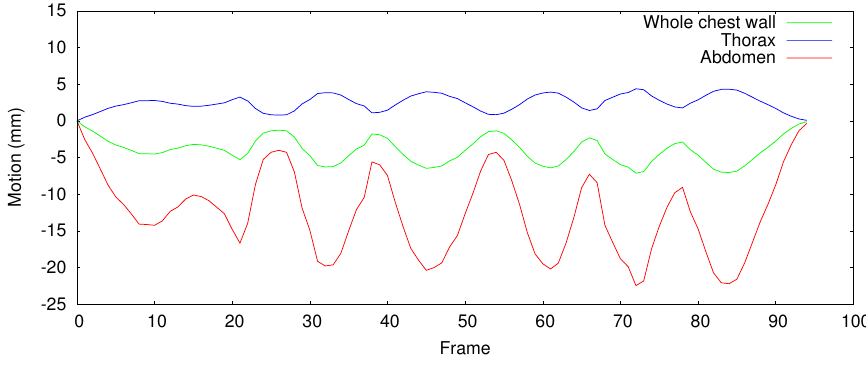
Figure 15. Respiratory motion graph of a volunteer performing the isovolume maneuver. The opposite phase of the whole thorax and the whole abdomen motion reflect the volume exchange between